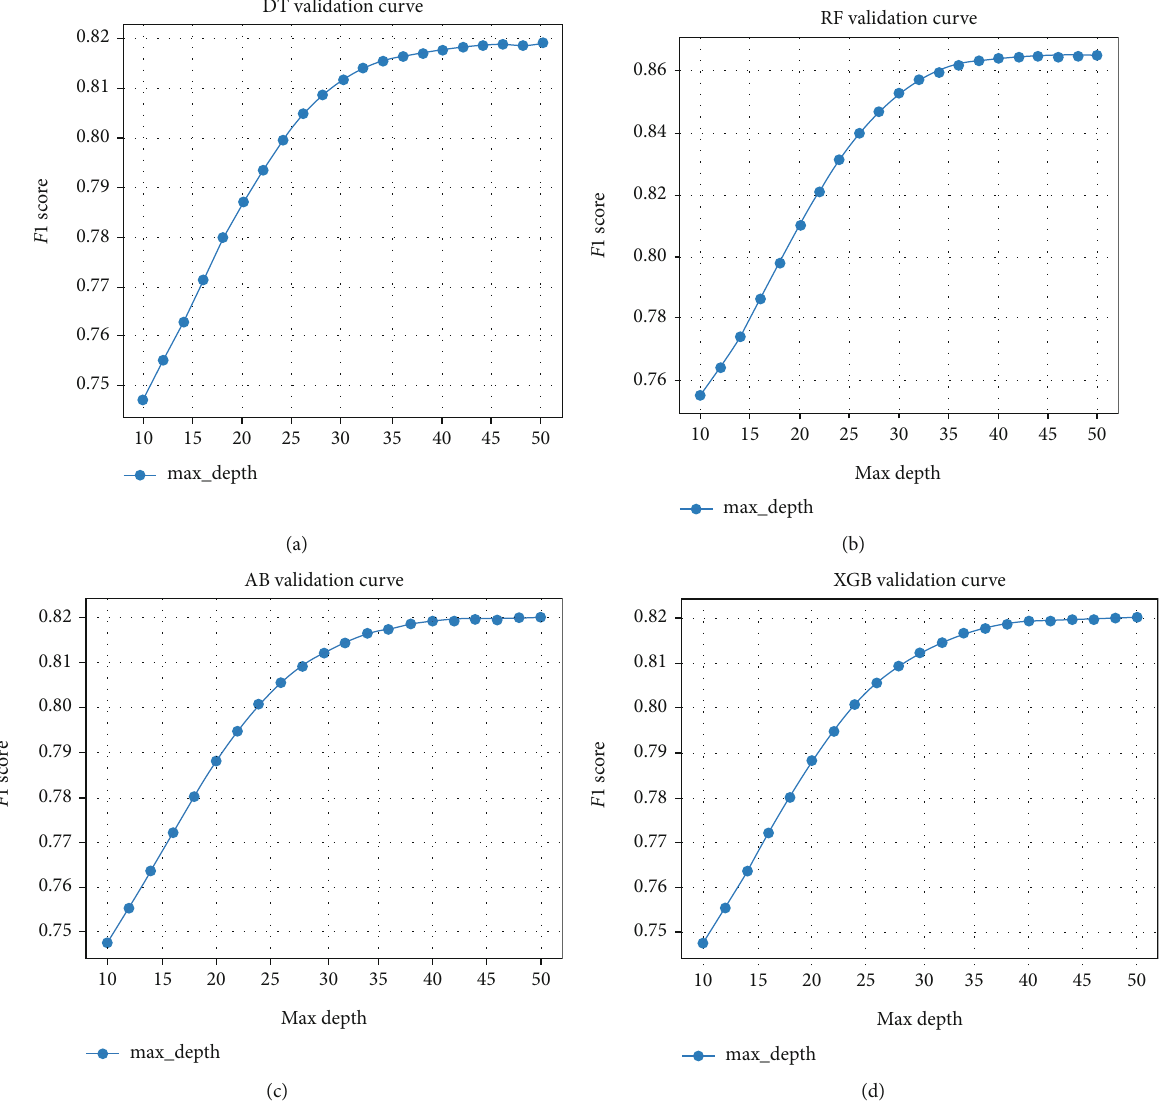
Figure 2: Parameter selection process of the prediction model constructed by four classi fi cation tree models: (a) decision tree, (b) random forest, (c) AdaBoost, and (d) XGBoost. Note: the score of F ‐ 1 has been tested when the max depth parameter of the model is between 10 and